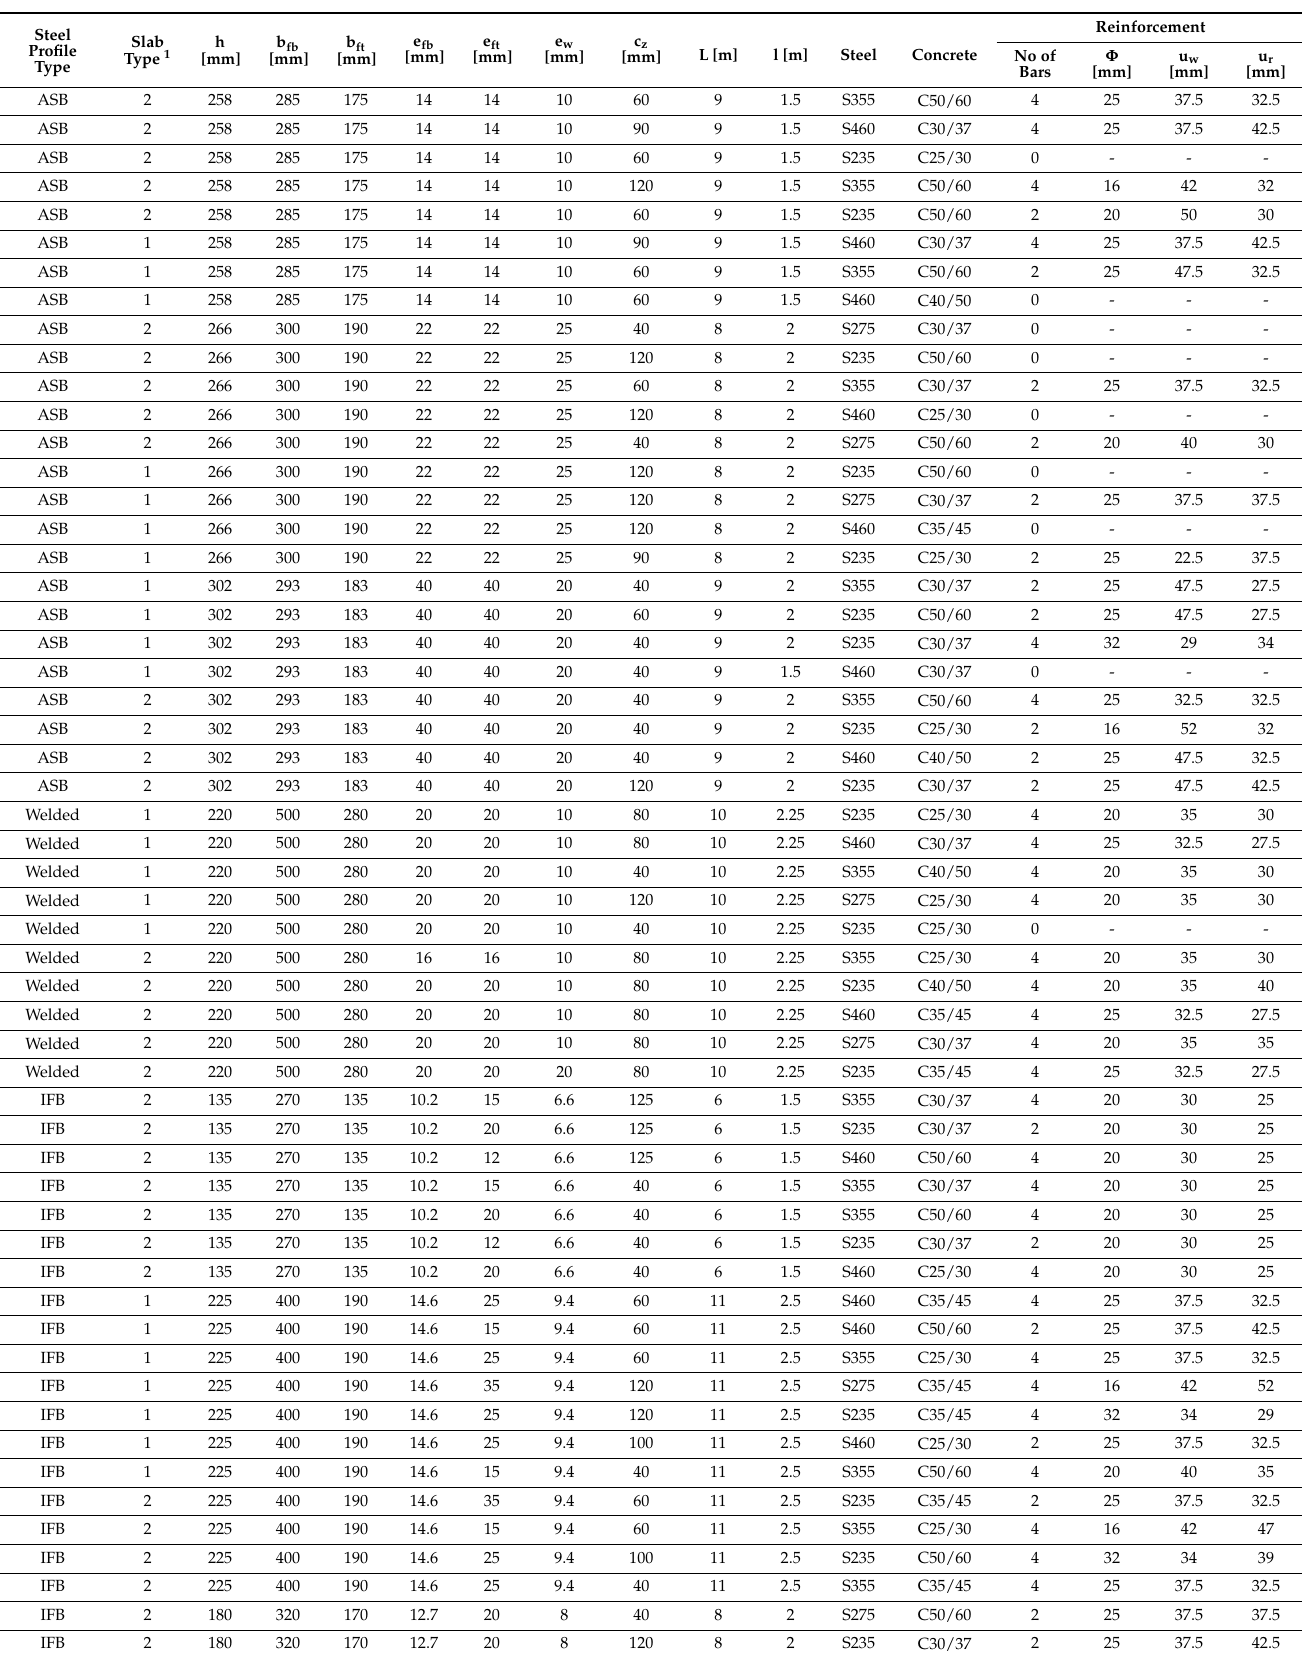
Table 5. The evaluated geometrical